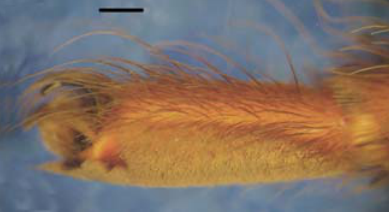
Image 15. Tarsus IV, Cracked tarsi. Scale 1.0mm